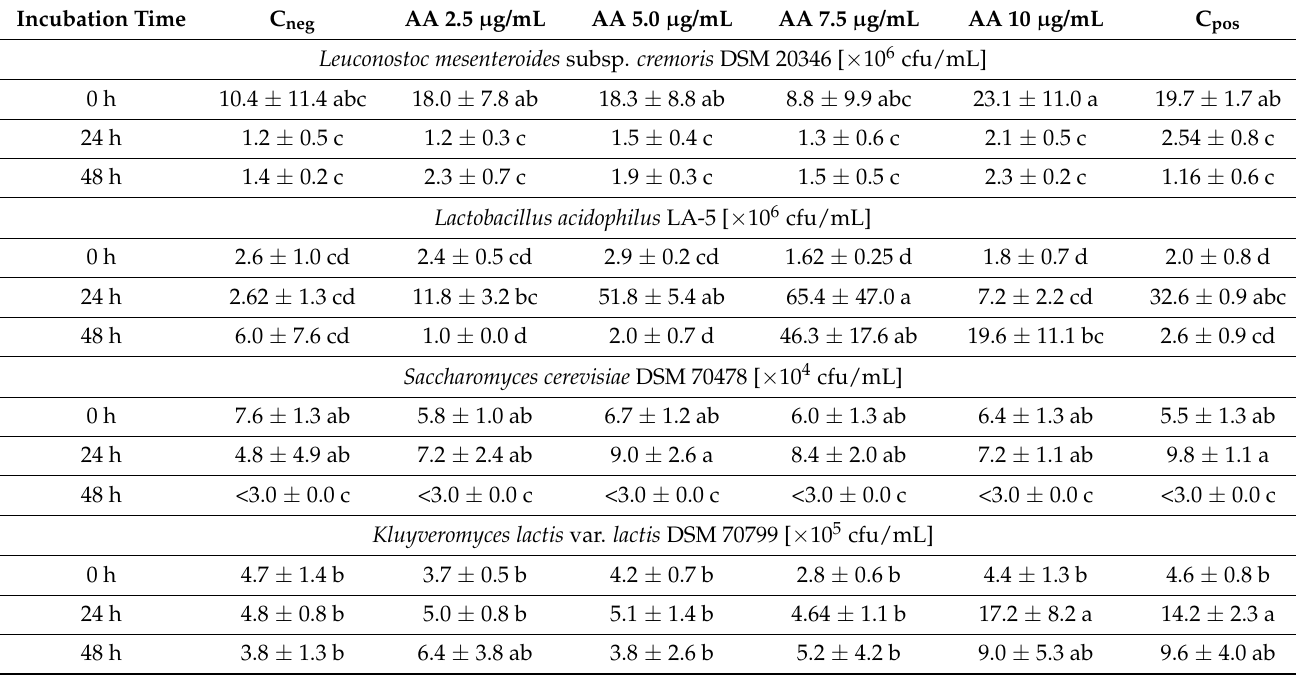
The same letters below the values within the results for particular microorganism indicate the lack of statistical differences at p < 0.05. C pos –positive control (9 mL of MRD inoculated with 1 mL microbial suspension), C neg –negative control (8 mL of MRD inoculated with 1 mL of microbial suspension and 1 mL of sterile water). For DSM 70,478 the number of yeast colonies after 48 h was <30 on the plate or they were not detected at all. Thus, the results are presented as <3.0 ± 0.0 (the lowest sample dilution spread on the plate with YM medium was 10 − 3